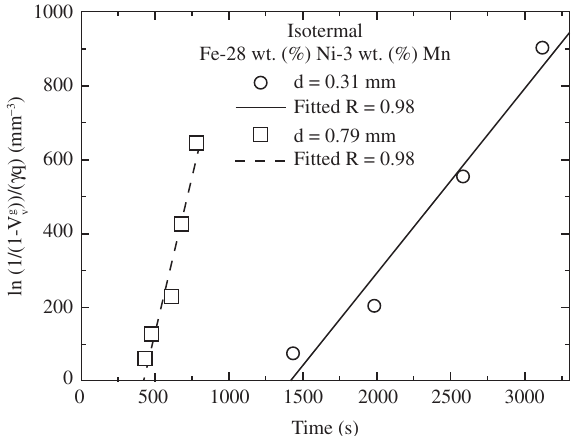
Figure 3. Isothermal martensite experimental data from a Fe-23. wt. (%) Ni-2.8 wt. (%) Mn alloy obtained by Ghosh 10,11 plotted after Equation 17. The correlation coefficients, R, are also